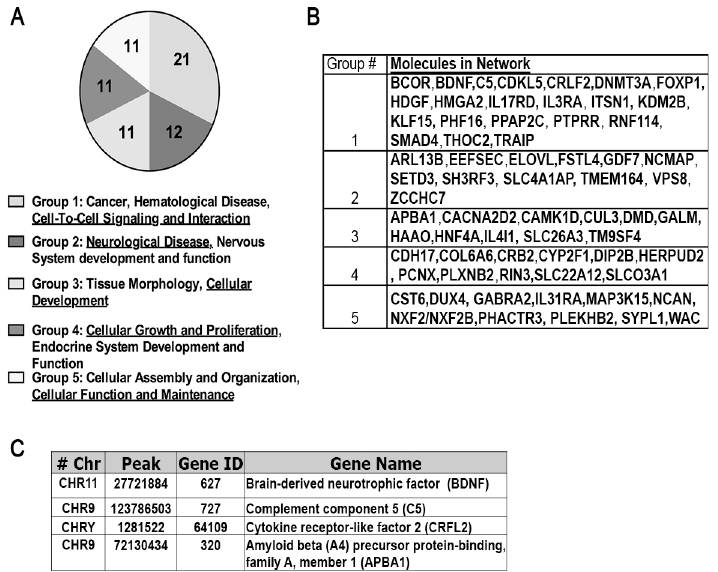
Fig 2. ChIP-seq analysis of PMA-differentiated THP-1 macrophage cells and IPA analysis. THP-1-Tat- Flag cell lines 5, 8, and 13, and THP-1-luciferase cell lines were treated for 24 hours with PMA and Chromatin Immunoprecipitationwas performed.Cell lysates were prepared,precleared,and then immunoprecipitated with anti-Flag antibody.The DNA associated with Tat-Flag was recoveredand librarieswere generatedfor IlluminaChIP-Seq. The librarieswere massively parallelsequenced, and analyzedwith RefSeq, using hg19 humanreference genome(see Methods). (A) Ingenuity Pathway Analysis (IPA) of the 66 genesidentifiedby ChIP-seq analysis. We found 21 genesin Group 1, Cancer, Hematologicaldisease,Cell-To-Cell Signaling and Interaction; 12 genesin Group 2, NeurologicalDisease, Nervous System development and function; 11 genesin Group 3, Tissue Morphology,CellularDevelopment; 11 genes in Group 4, CellularGrowth and proliferation, endocrine system Development and Function; and 11 genesin Group 5, CellularAssemblyand Organization, CellularFunction and Maintenance. (B) List of genesfound by ChIP-seq classifiedin the five groupsfound by IPA. (C) Four genes (C5, CRLF2, APBA1, and BDNF) from the 66 genesassociatedwith the Tat-Flag complex identifiedby ChIP-seq analysis, that have a potentialrole in inflammation, chemotaxis, and neuronalfunction were selectedfor subsequent study. Columns indicatethe chromosomenumber, start of the peak, gene ID, and gene